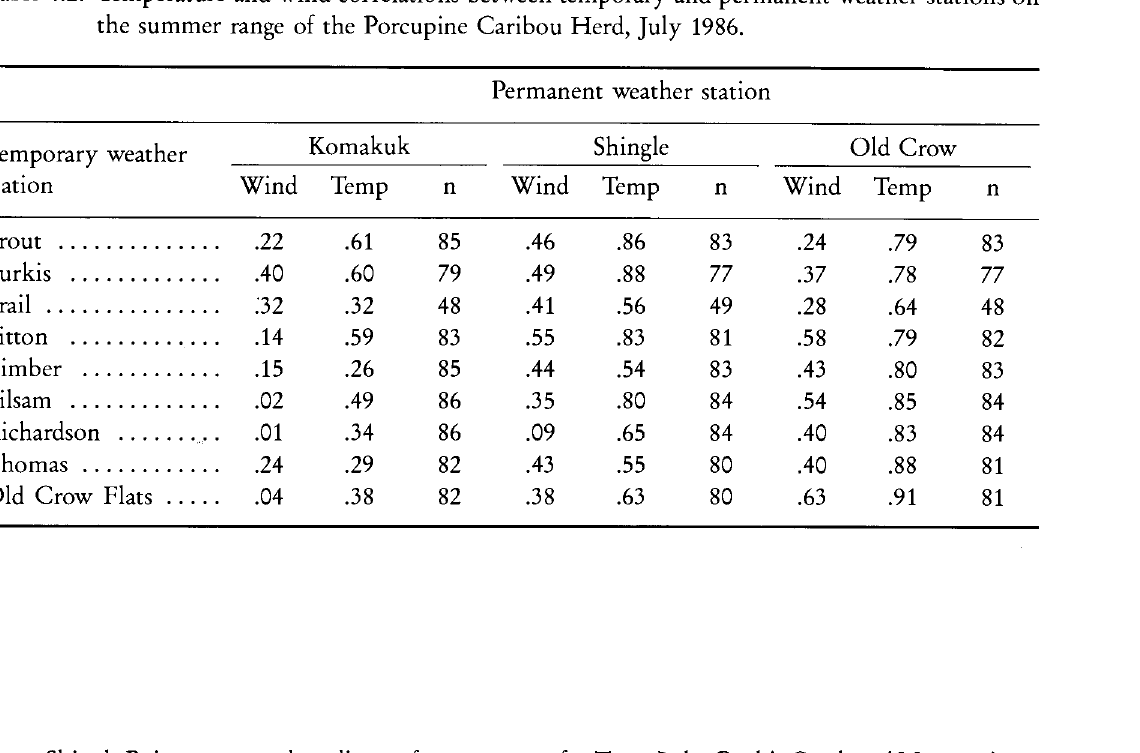
Table 4.2. Temperature and wind correlations between temporary and permanent weather stations on the summer range of the Porcupine Caribou Herd, July